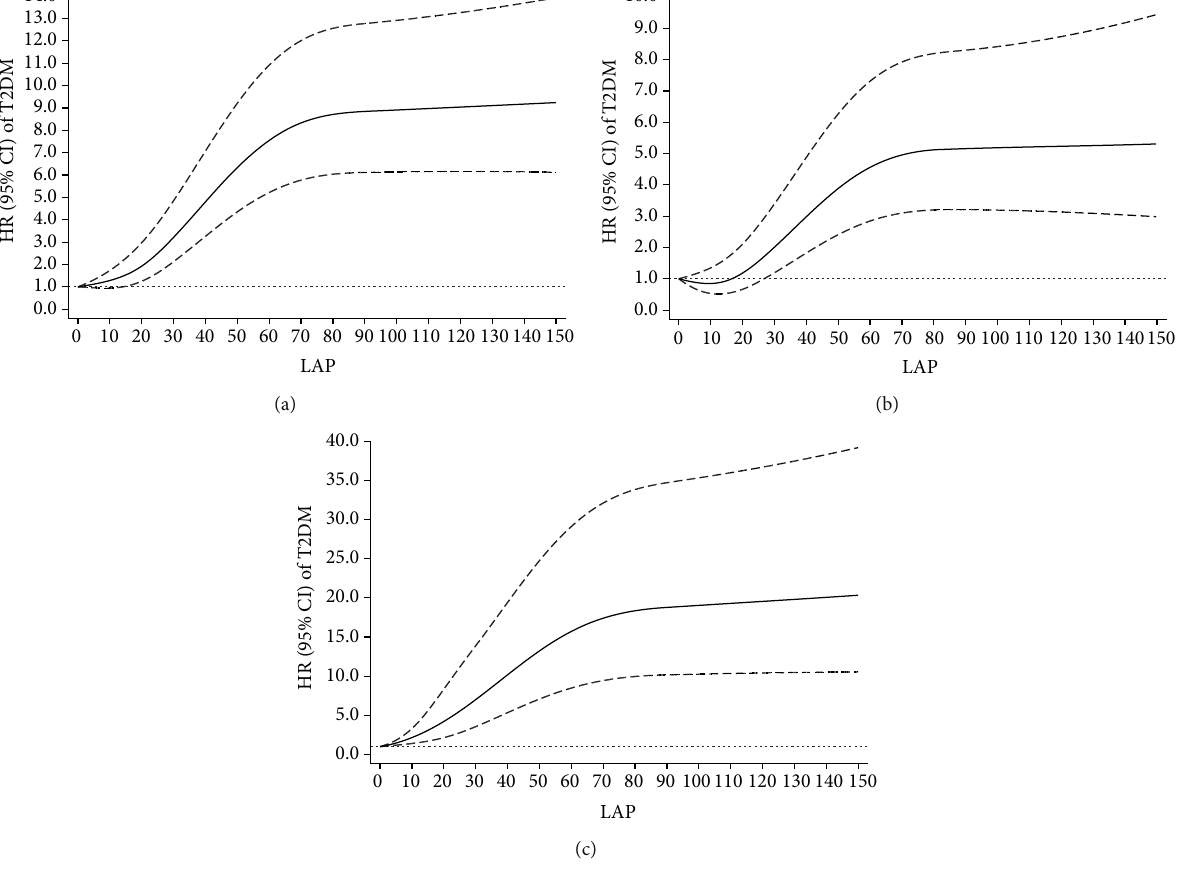
Figure 2: Nonlinear associations of lipid accumulation product (LAP) and risk of type 2 diabetes mellitus (T2DM) by using restricted cubic splines with 4 knots in all (a), men (b), and women (c). Adjustment was for age, sex, smoking status, drinking status, physical activity, family history of T2DM, family income, and education. HR: hazard ratio; CI: con fi dence interval; T2DM: type 2 diabetes